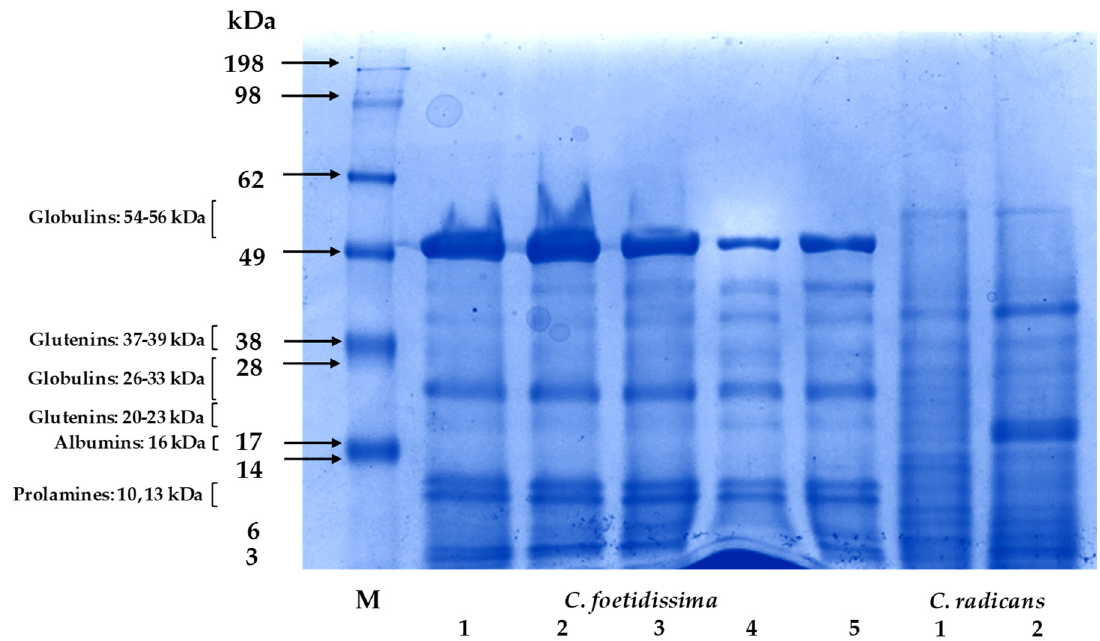
Figure 4. Phenolic compound profiles of fruits of wild Cucurbita species. Phenolic compound profiles of seeds, pulp and peel of C. foetidissima and C. radicans fruits were obtained by HPTLC analysis. The fruits were sampled in 2018 from plants growing in the wild in two different locations in the state of Jalisco, México: Vaquerías, municipality of Ojuelos ( C. foetidissima ), and San José de Gracia, municipality of Tepatitlán ( C. radicans ). The TLC-separation of methanolic extracts was visualized under UV light (366 nm) after derivatization with the Natural Products reagent. The red arrows indicate bands whose Rf values corresponded to those of reported standards (Std): Rutin and chlorogenic acid. C. fma. = Cucurbita foetidissima .